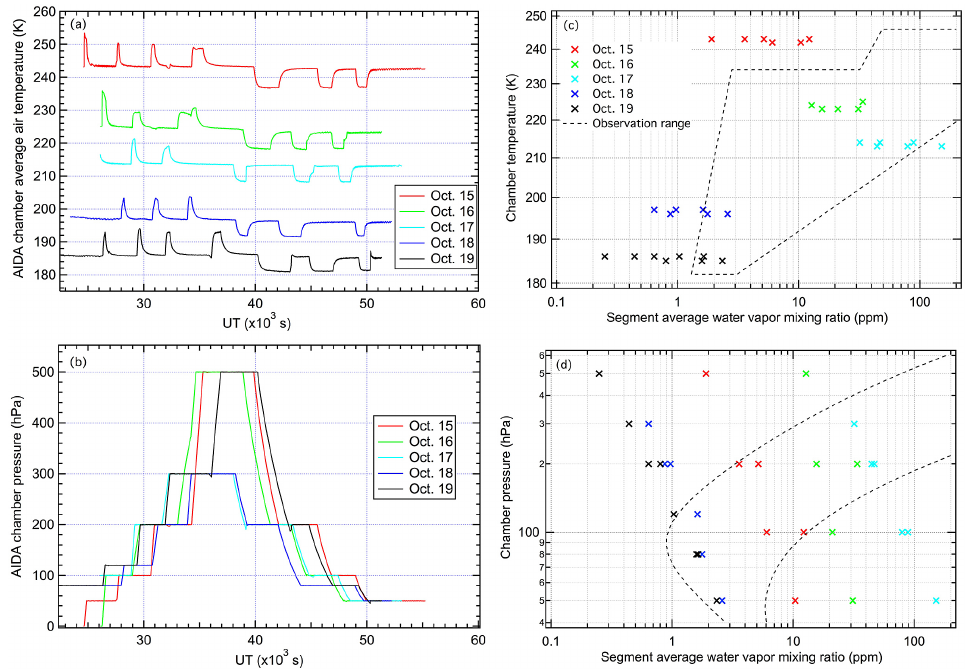
Figure 4. Time series of temperatures (a) , pressures (b) , and the relationship of chamber pressure and temperature with water vapor mixing ratios ( c and d ) for all segments during the experiments (also see Table 3). The dashed lines indicate the nominal range of conditions observed by the HWV instrument in tropical and midlatitude flights during the last decade. During the two lowest-temperature experiments (18 and 19 October), humidity in the chamber was controlled by ice cover on the chamber